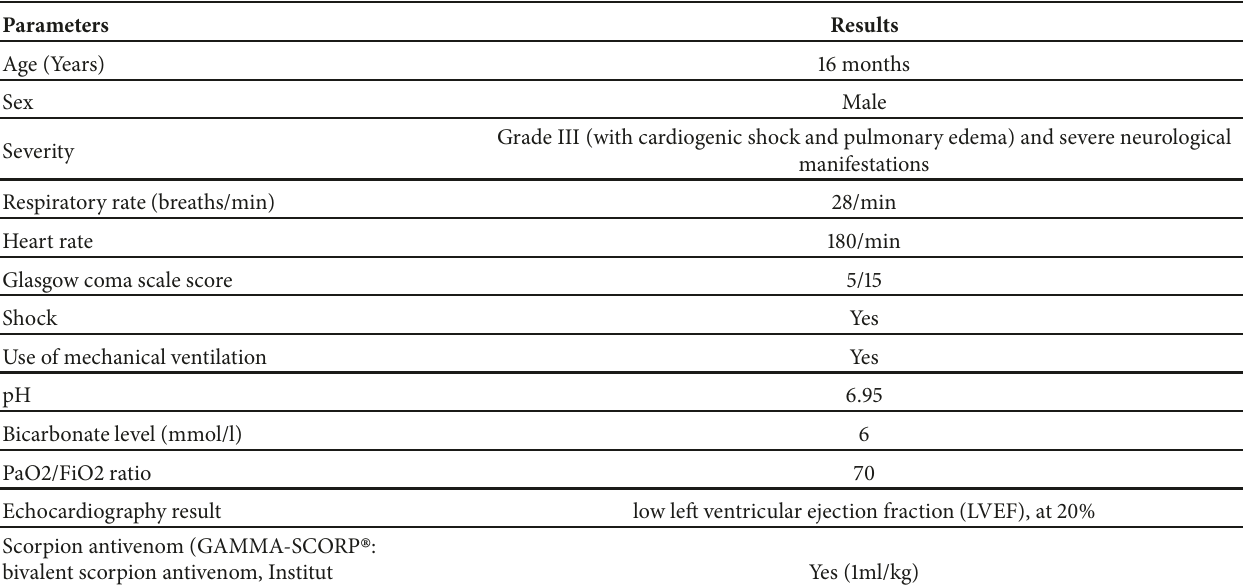
Table 1: Clinical parameters recorded on ICU admission.